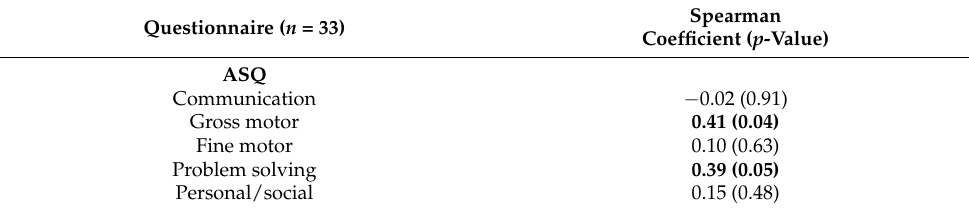
Table A5. Fully adjusted correlation between breastfeeding category and questionnaire